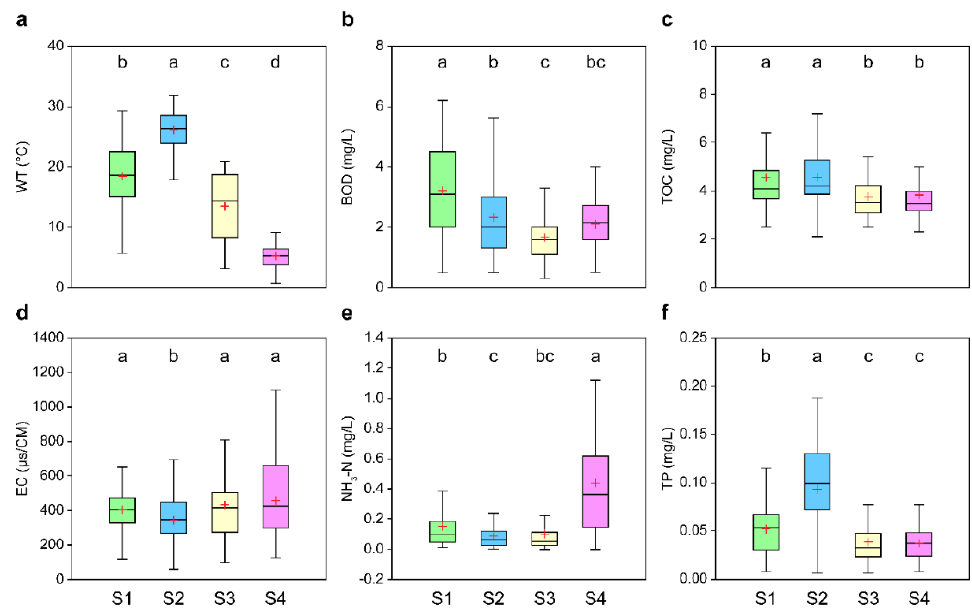
Figure 6. Box plots of the temporal stepwise mode discriminant function. The middle line of each box represents the median value, the lower line represents the first quartile (25%), the upper line represents the third quartile (75%), the lower bar represents the minimum (median-1.5 × interquartile range; IQR), and the upper bar represents the maximum (median + 1.5 × IQR); the red cross mark indicates the average value. IQR is the third quartile minus the first quartile, and the letters above the box plot represent the results of the Scheffe Test ( p < 0.05). ( a ): water temperature; ( b ): biochemical oxygen demand; ( c ): total organic carbon; ( d ): electrical conductivity; ( e ): ammonia-nitrogen; ( f ): total